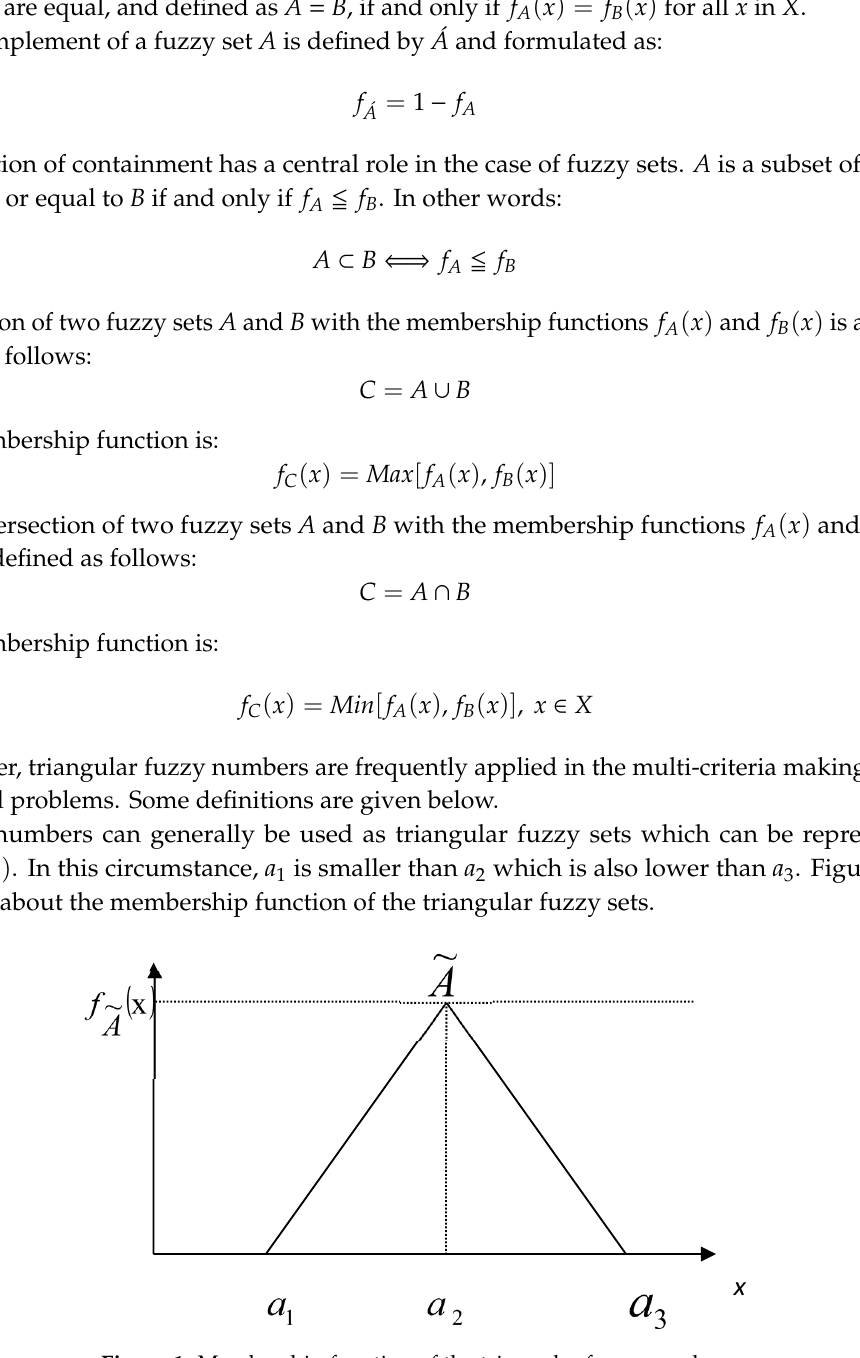
Figure 1. Membership function of the triangular fuzzy number.